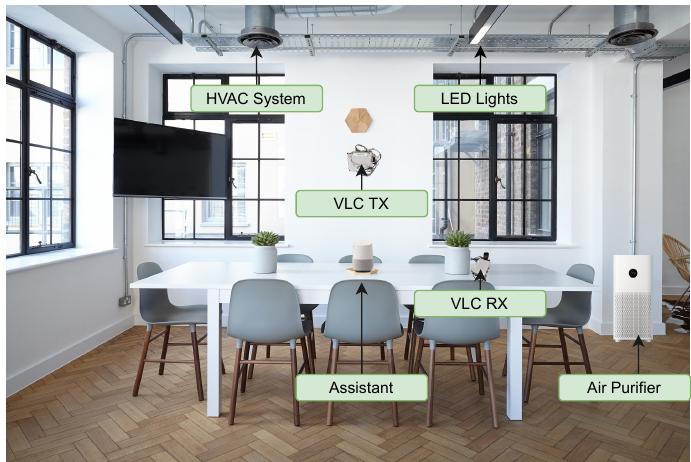
Figure 1. Smart office